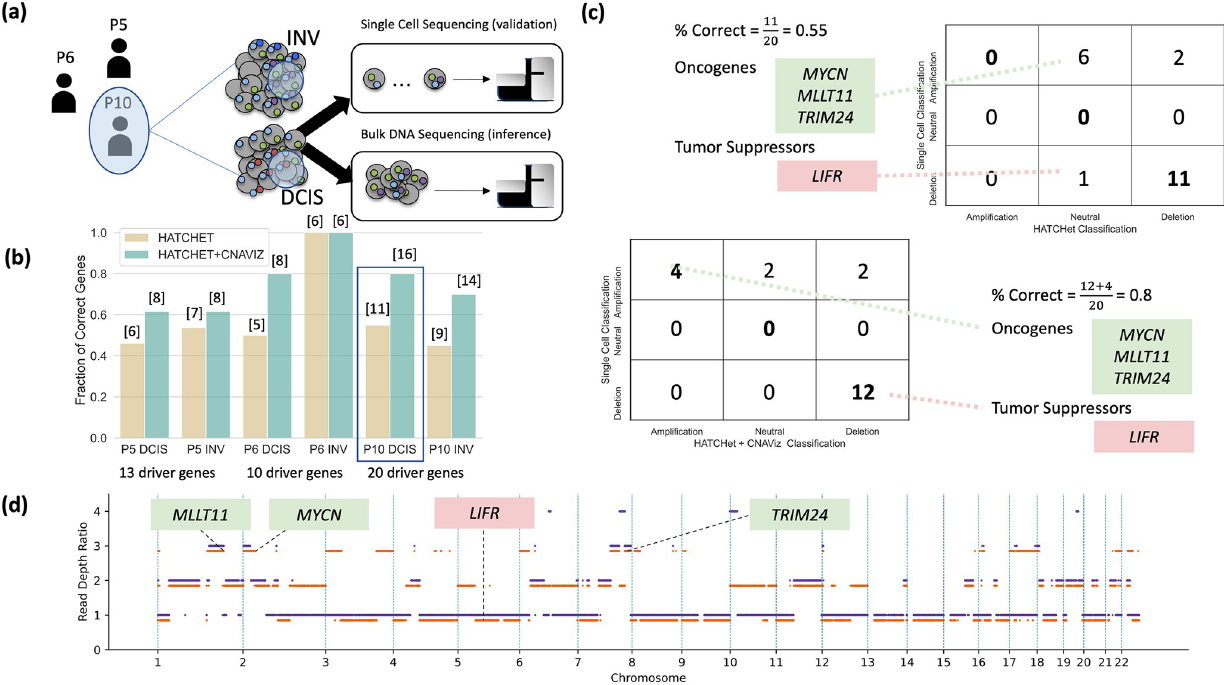
Fig 5. Manual editing using CNAViz results in more accurate identification of CNA status of breast cancer driver genes compared to an existing segmentation algorithm. The DNA sequencing data of two tumor samples (DCIS and INV) obtained from each of three breast cancer patients (P5, P6, and P10) analyzed by [27]. (b) The number of correctly identified CNAs for breast cancer driver genes ( y -axis) is reported across all samples of the three patients when using either the existing segmentation algorithm HATCHet (yellow) or after manual refinement of the HATCHet results with CNAV IZ (green). The number of correct driver genes is listed above each bar. (c) The number of breast-cancer driver genes with different types of CNAs inferred by either HATCHet (columns in top table) or HATCHet + CNAV IZ (columns in bottom table) is compared with the high-resolution CNAs measured by the matched classification in single-cell sequencing data (rows in both tables). (d) The CNAs ( y -axis) inferred by HATCHet + CNAV IZ for two distinct sub- populations of cancer cells identified in Patient 10 are shown in orange and purple, with 0.15 separation for visual clarity.